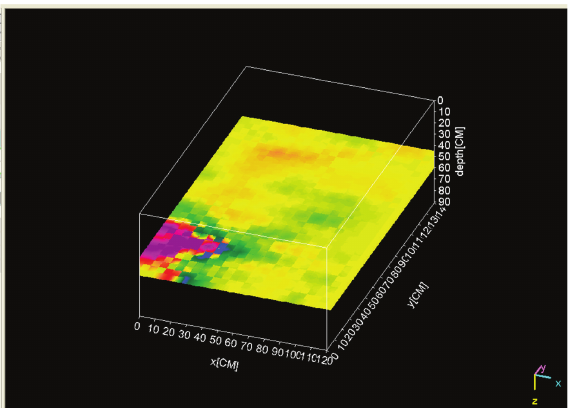
Figure 4: Constant depth slice at the depth of about 50 cm, achieved from migration.